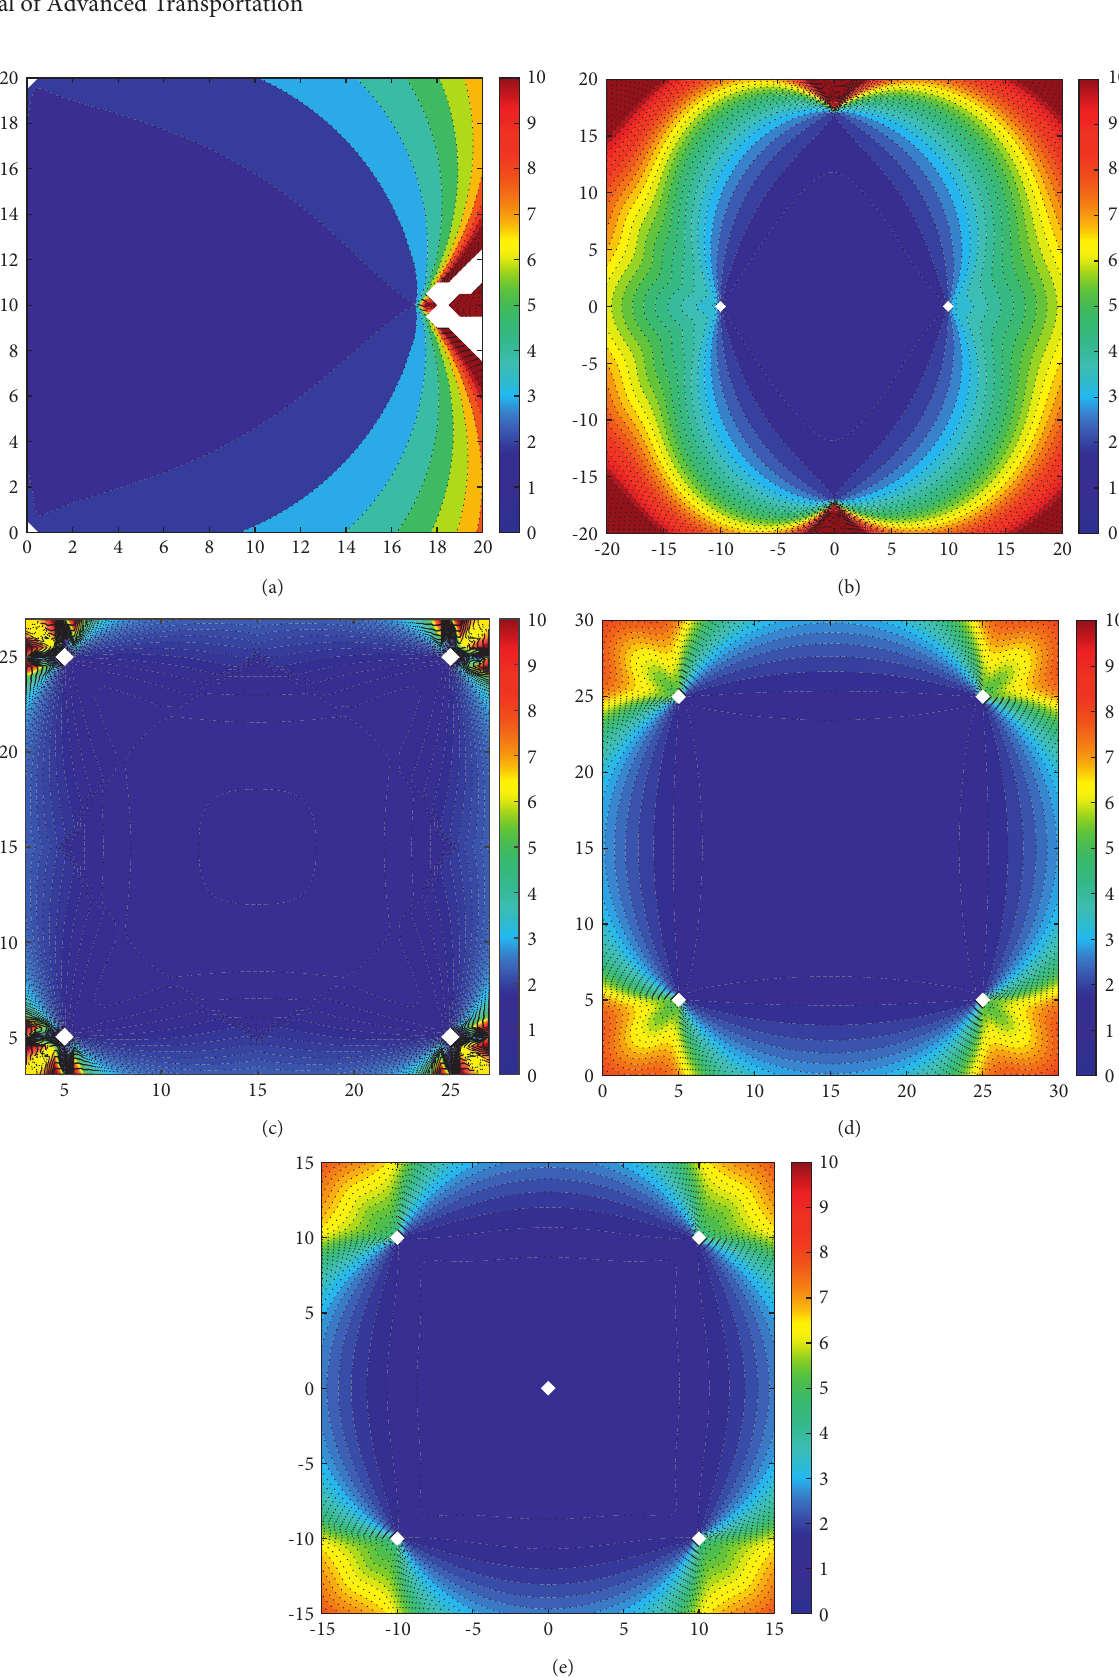
Figure 1: HDOP distribution map of positioning area for different numbers of BSs in a uniform layout; (a) triangle three times coverage; (b) triangle four times coverage; (c) square three times coverage; (d) square four times coverage; (e) square five times